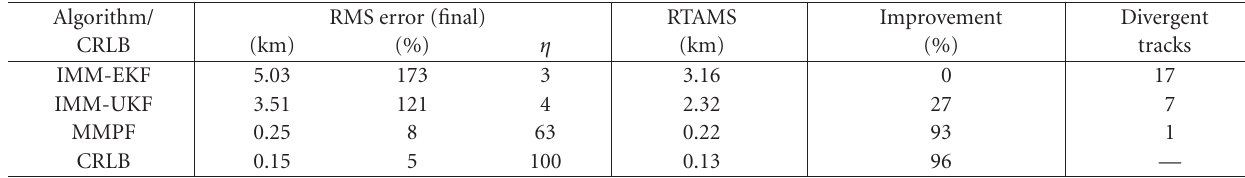
Table 2: Performance comparison for the multisensor case.